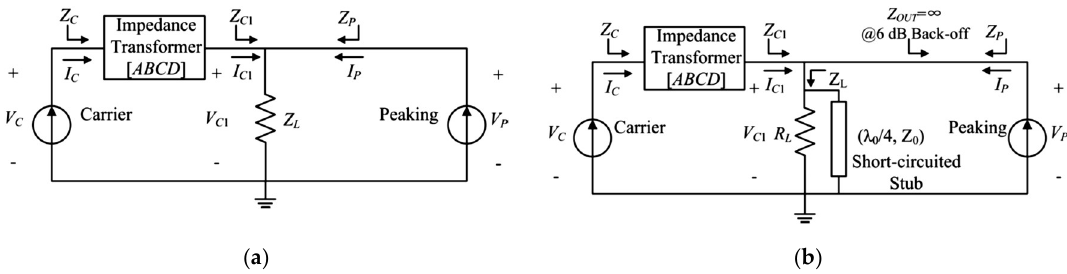
Figure 14. ( a ) Equivalent-circuit diagram of a DPA with the carrier and peaking amplifiers represented by current sources. ( b ) DPA using a shunted short-circuited stub